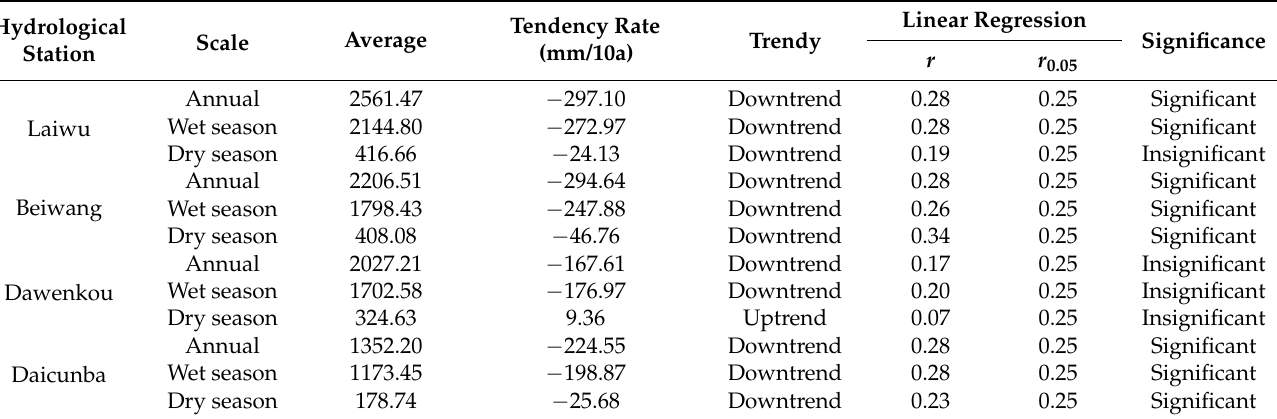
Figure 4. The trend analysis for annual runoff in the Dawen River Basin. Table 1. Variations in interannual runoff in the Dawen River